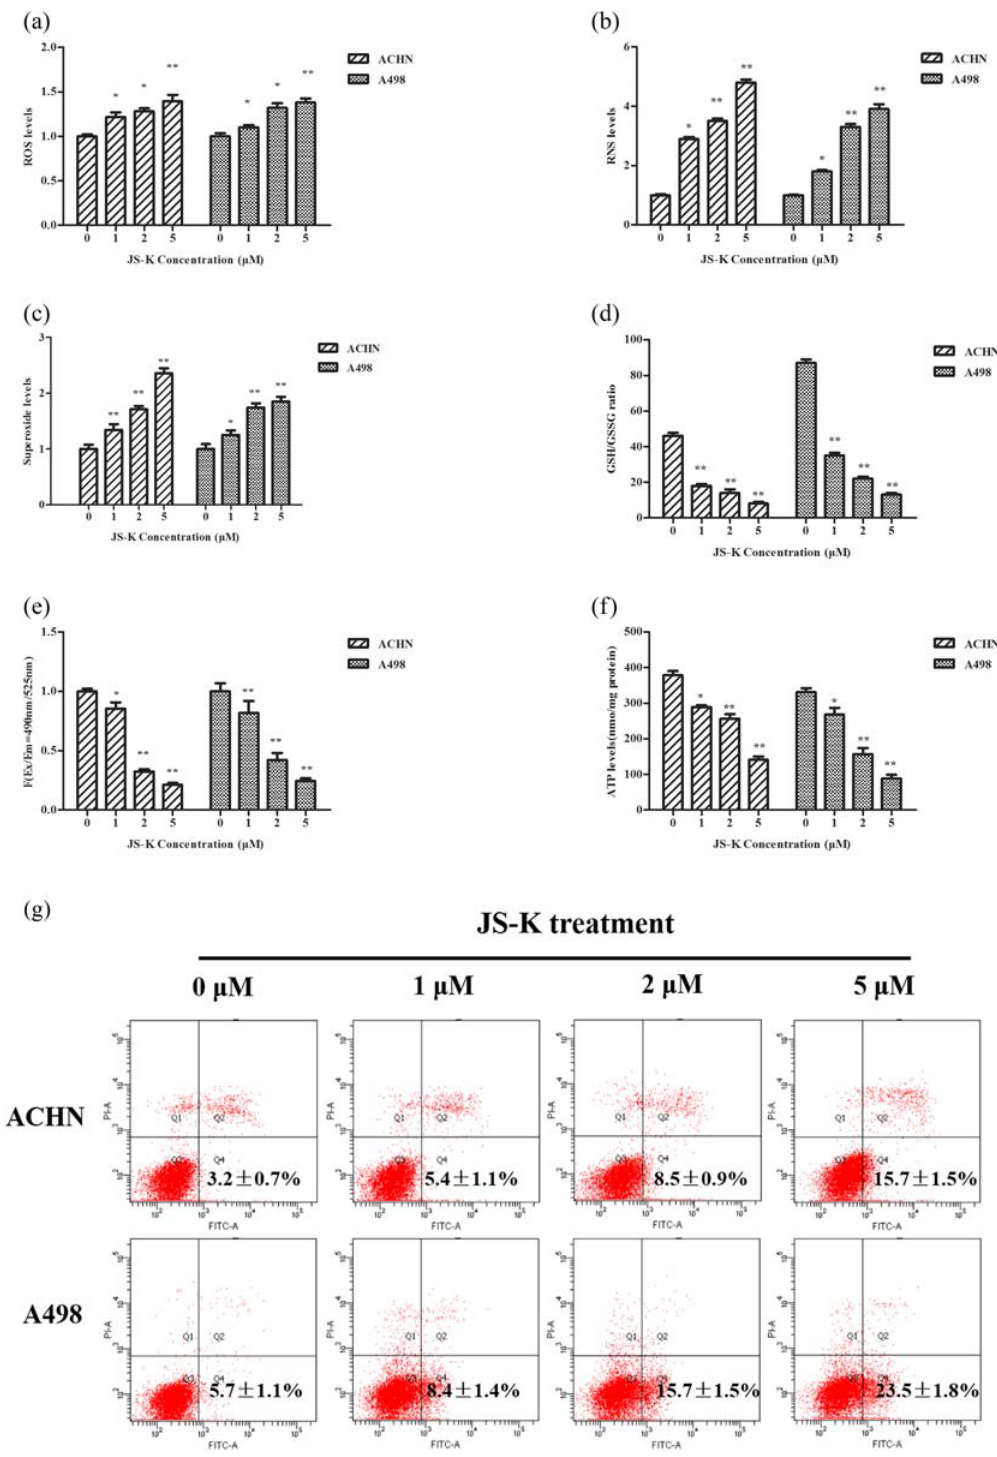
Figure 4: E ff ect of JS - K on ROS, RNS, mitochondrial membrane potential, GSH/GSSG ratio, ATP production, and apoptotic - related proteins in renal carcinoma cells. Treatment of JS - K renal carcinoma cells ( 0, 1, 2, and 5 μ M ) for 360 min, and then detection of intracellular maximum ROS ( a ) , RNS ( b ) , superoxide ( c ) , and GSH/GSSG ratio ( d ) levels. Upon 360 min of JS - K treatment, measurements were made for mito - chondrial membrane potential ( e ) and ATP output ( f and g ) . Western blot was used to identify concentrations of apoptotic - related proteins such as Bak, Bax. and PARP after cells were treated with JS - K ( 0, 1, 2, and 5 μ M ) for 24 h. For at least three separate assays, fi ndings are reported as mean ±